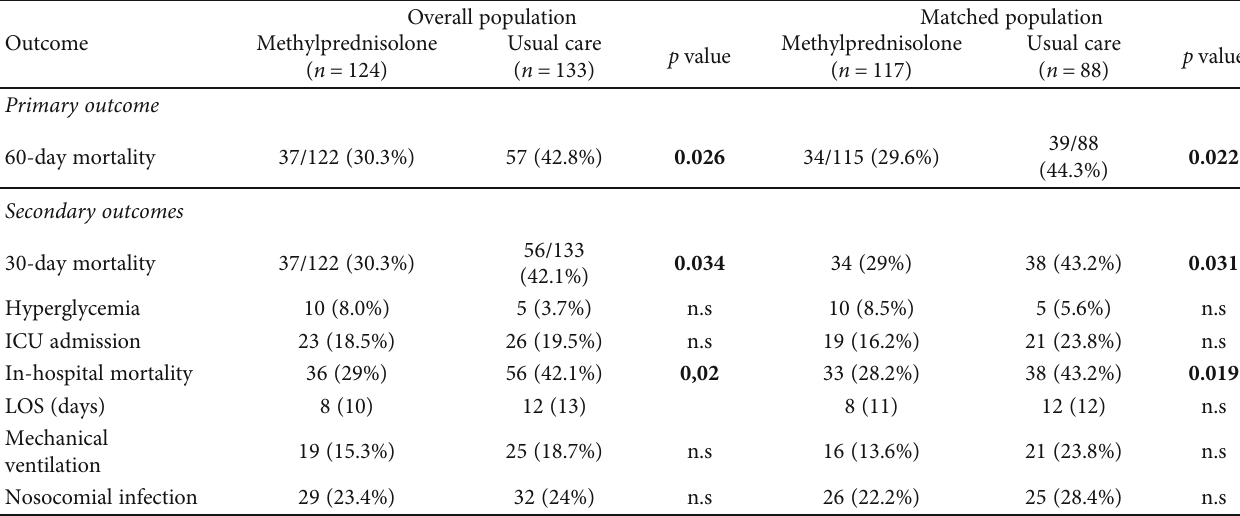
Table 2: Primary and secondary outcomes of the global and matched population.